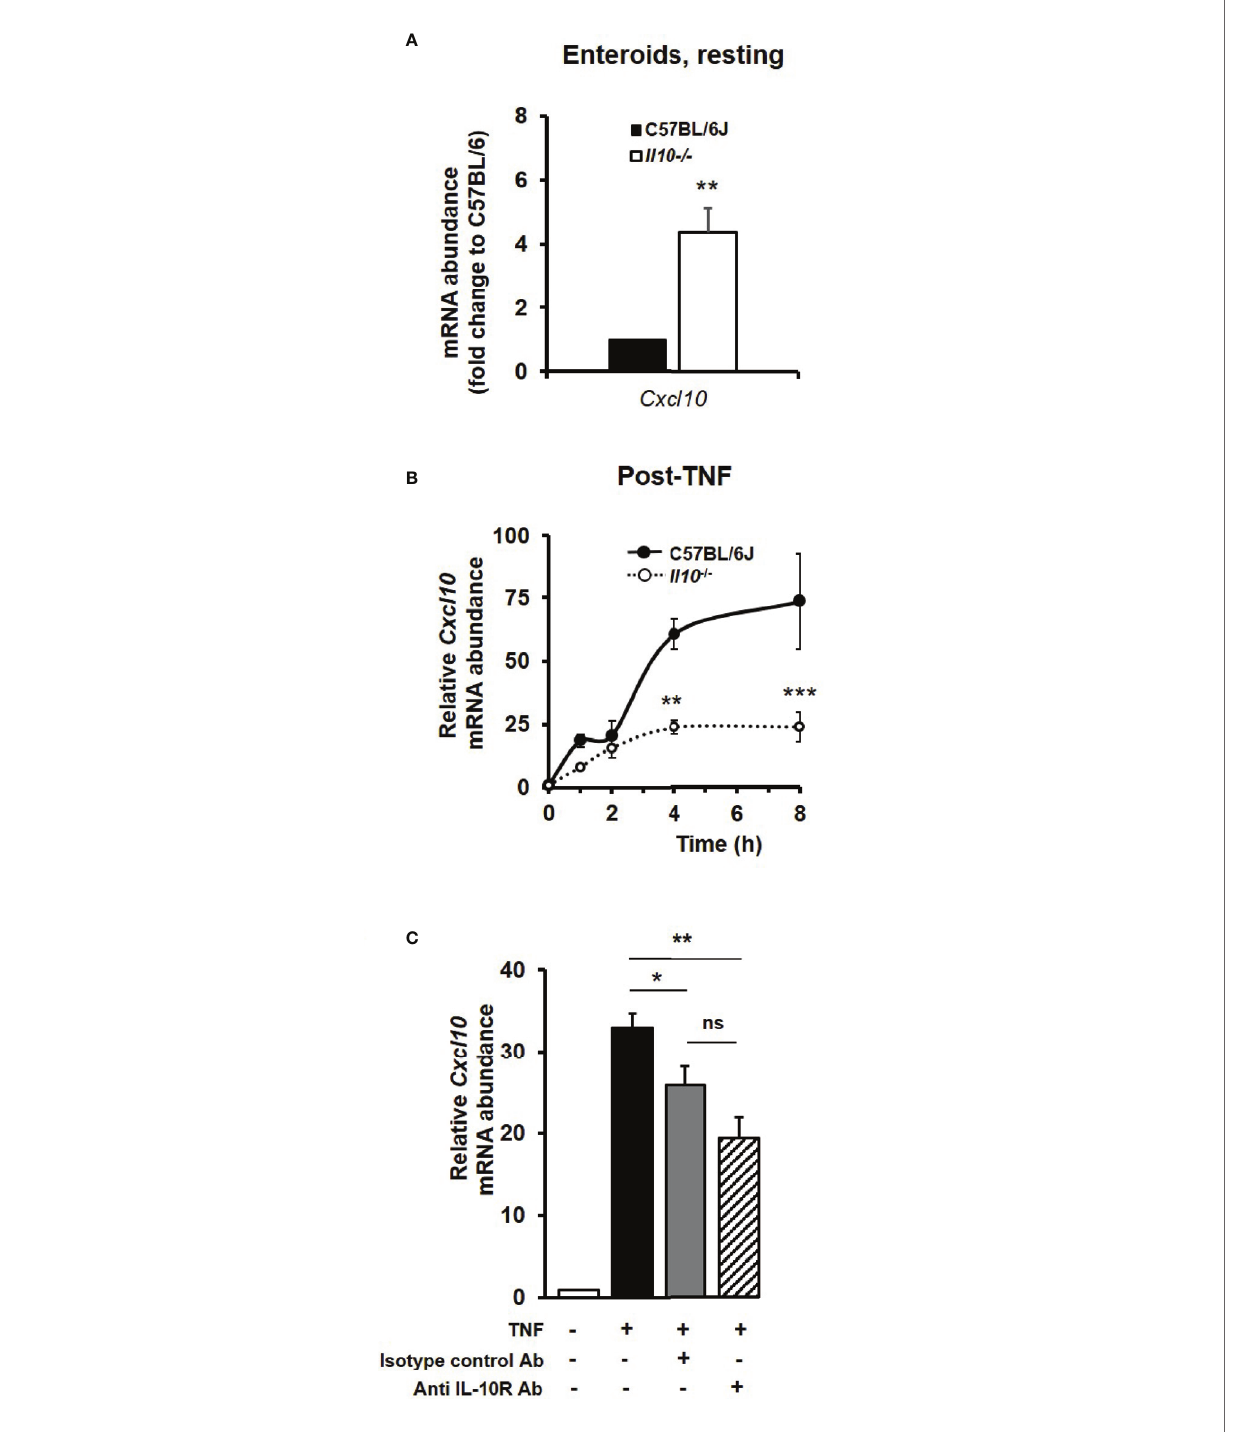
FIGURE 7 | The TNF-induced late response NF k B target gene Cxcl10 is dependent on IL-10/IL-10R signaling. Cxcl10 mRNA levels in enteroid cultures from C57BL/6J and Il10 − / − mice, (A) at rest, and (B) following treatment for 8 h with 40 ng/ml TNF. Signi fi cant differences of Il10 null enteroids compared to C57BL/6J controls, **p < 0.01 and ***p < 0.001 (N=3-4 mice, Kruskal – Wallis test). (C) Assessment of Cxcl10 mRNA levels (as measured by qPCR) following overnight immunoblockade with rat anti-mouse IL-10 receptor (IL-10R) antibody (Ab) or using rat IgG1, k isotype control, stimulated with 40 ng/ml TNF for 8 h. Signi fi cant differences compared to enteroids stimulated with TNF alone as per Kruskal – Wallis test; * p < 0.05 and ** p < 0.01. ns, no signi fi cant difference between TNF plus anti-IL-10R and TNF plus isotype control antibody treatments ( p = 0.18). All data presented as mean ± SEM; N = 3 – 4